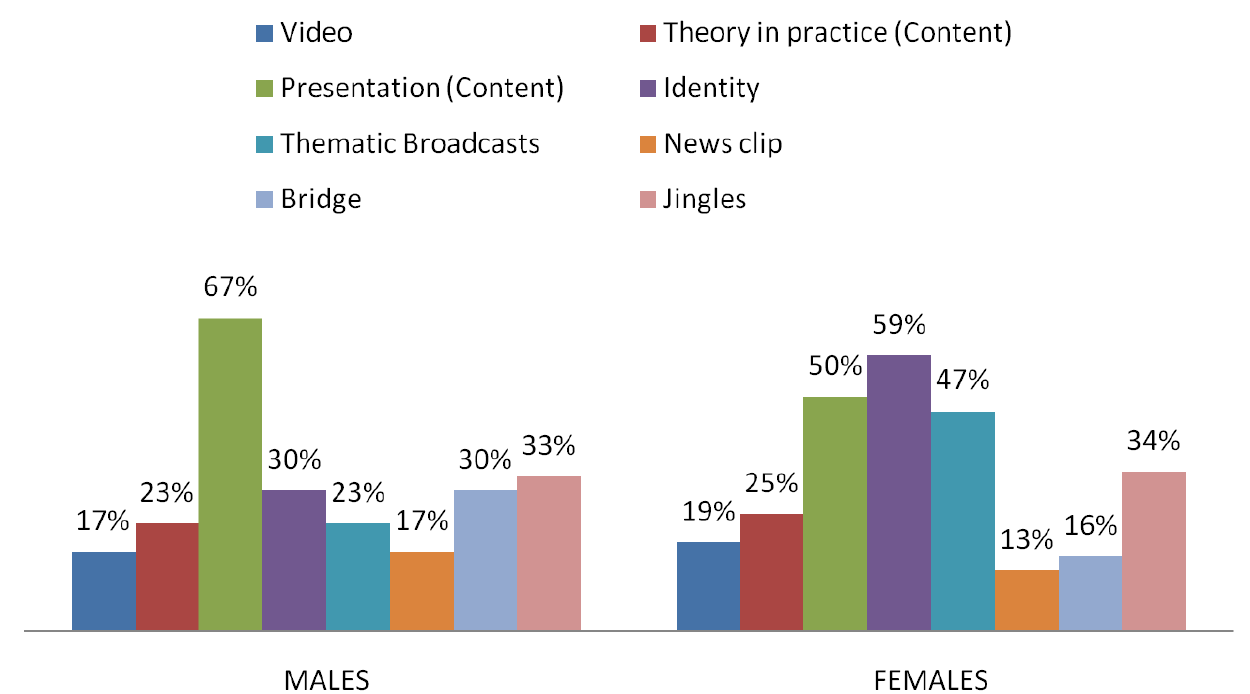
Figure 6. Grouped and adjusted qualitative data as quantitative data from the second part of the evaluation form based in gender.